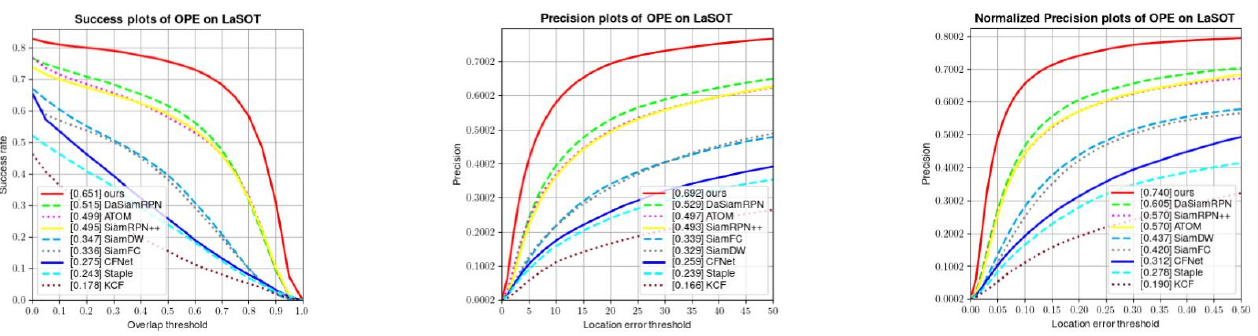
Figure 8. Performance of different algorithms on the LaSOT dataset. Table 4. Comparison on LaSOT. The best three results are marked in red, green, and blue bold fonts, respectively.